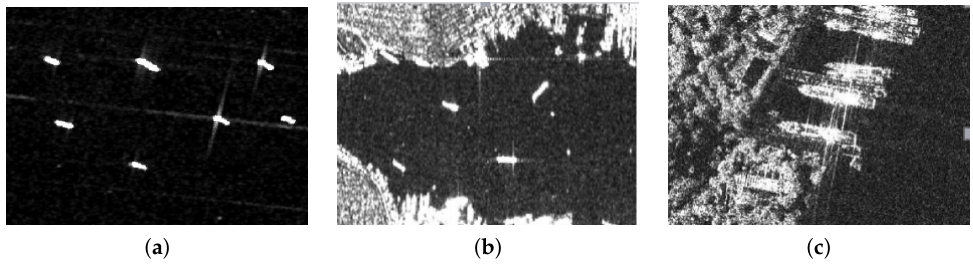
Figure 8. Some samples from SSDD. ( a ) Simple background, ( b ) complex background, ( c ) nearshore